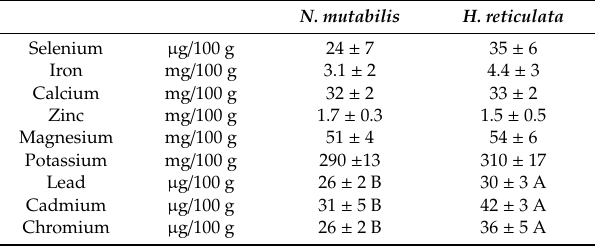
Table4. Element concentration determined in the meat of the two species of sea snails (mean value ± std.